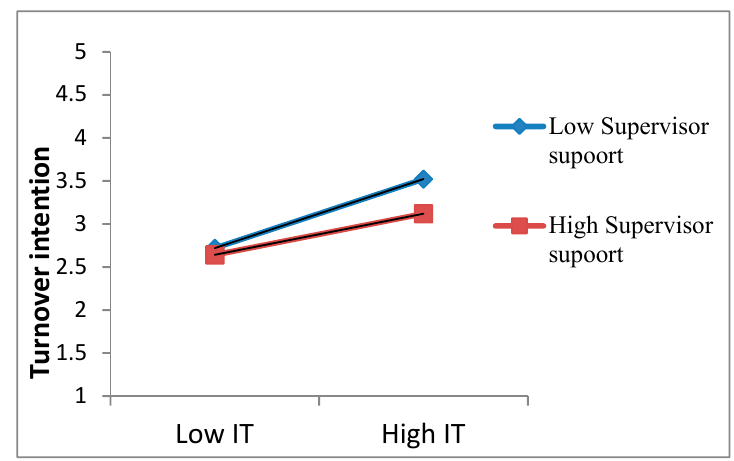
Figure 2. The moderator role of supervisor support on the relationship between illegitimate tasks and turnover intention.